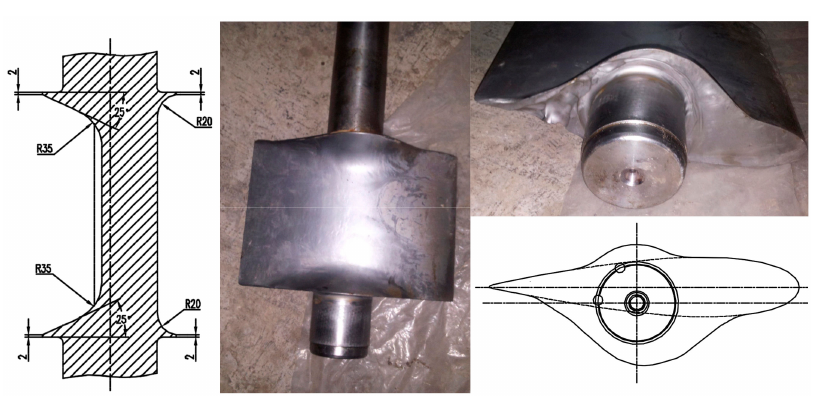
Figure 6. Guide vane with a large eccentric